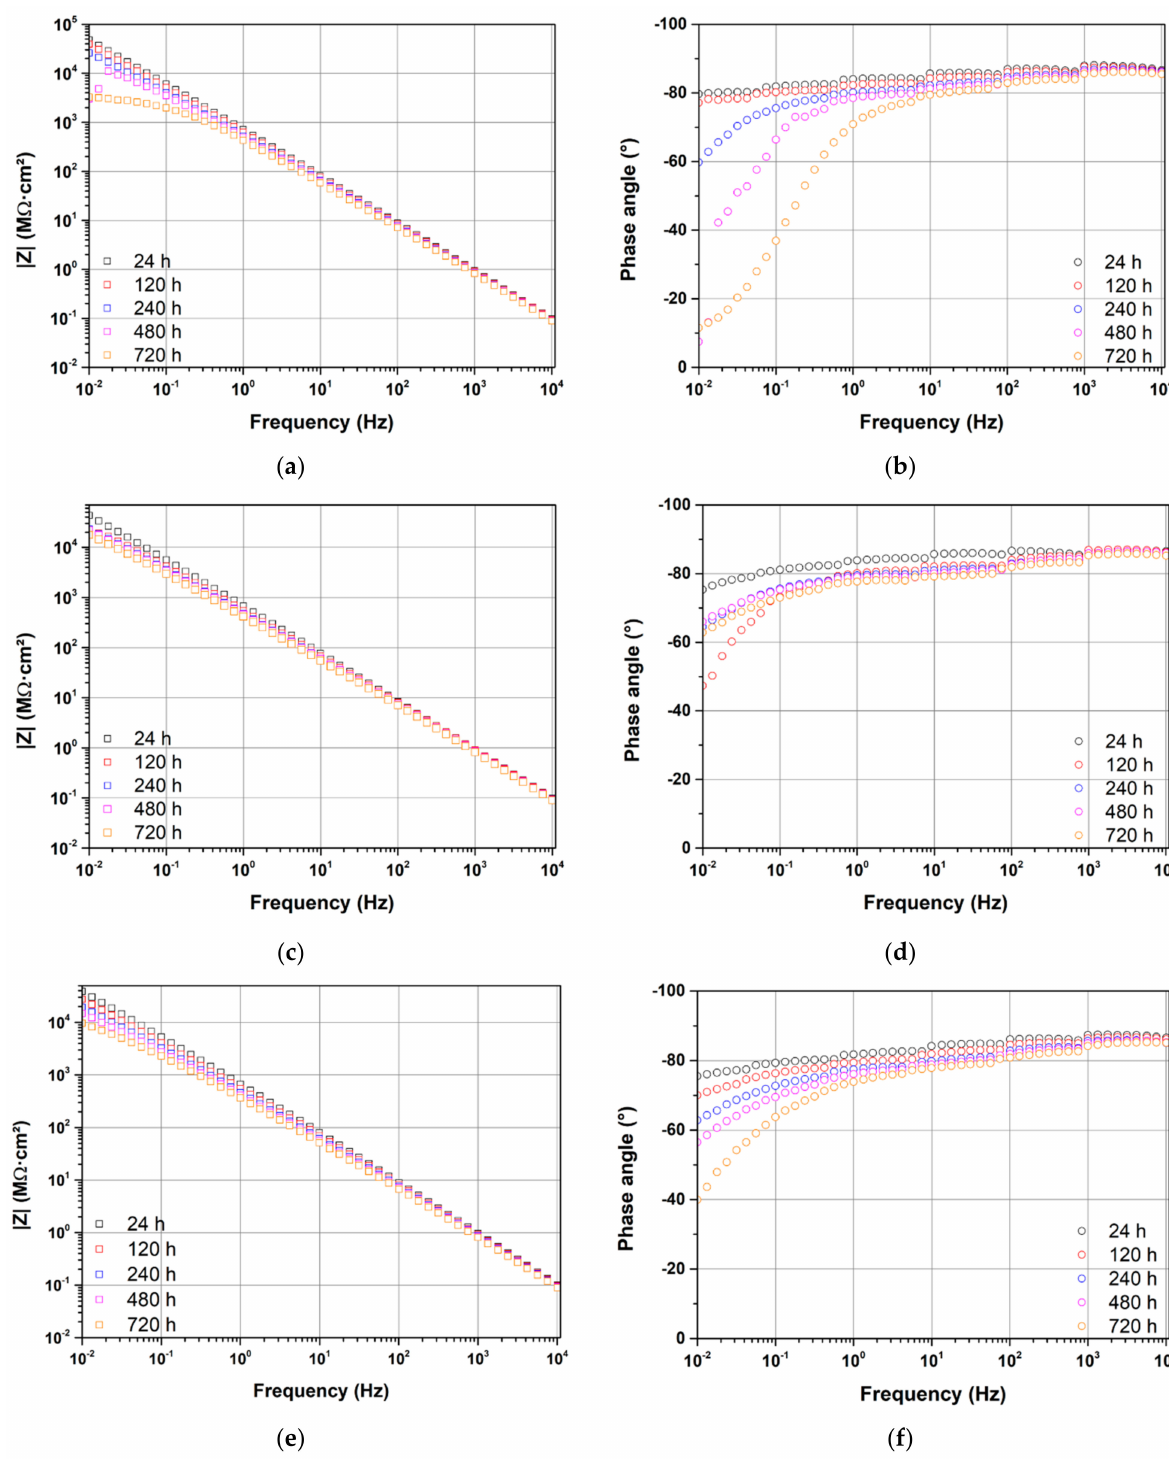
Figure 7. Electrochemical impedance spectra 1% NaCl for painted HDG steel as a function of the time of exposure ( a ) impedance modulus and ( b ) phase angle for the neutral cleaner (pH = 8), ( c ) impedance modulus and ( d ) phase angle for the mild alkaline cleaner (pH ≈ 10), ( e ) impedance modulus and ( f ) phase angle for the strong alkaline cleaner (pH >